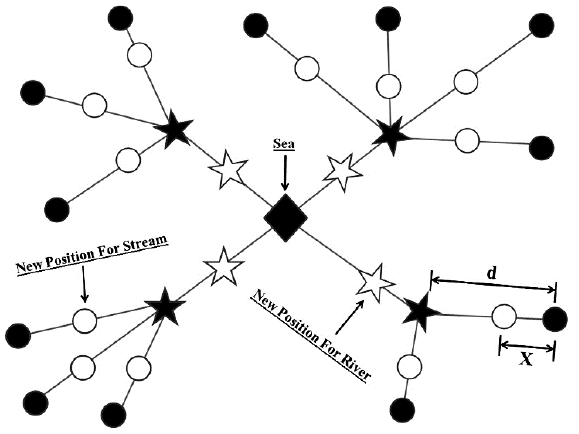
Figure 3. Schematic view for water cycle algorithm [38].